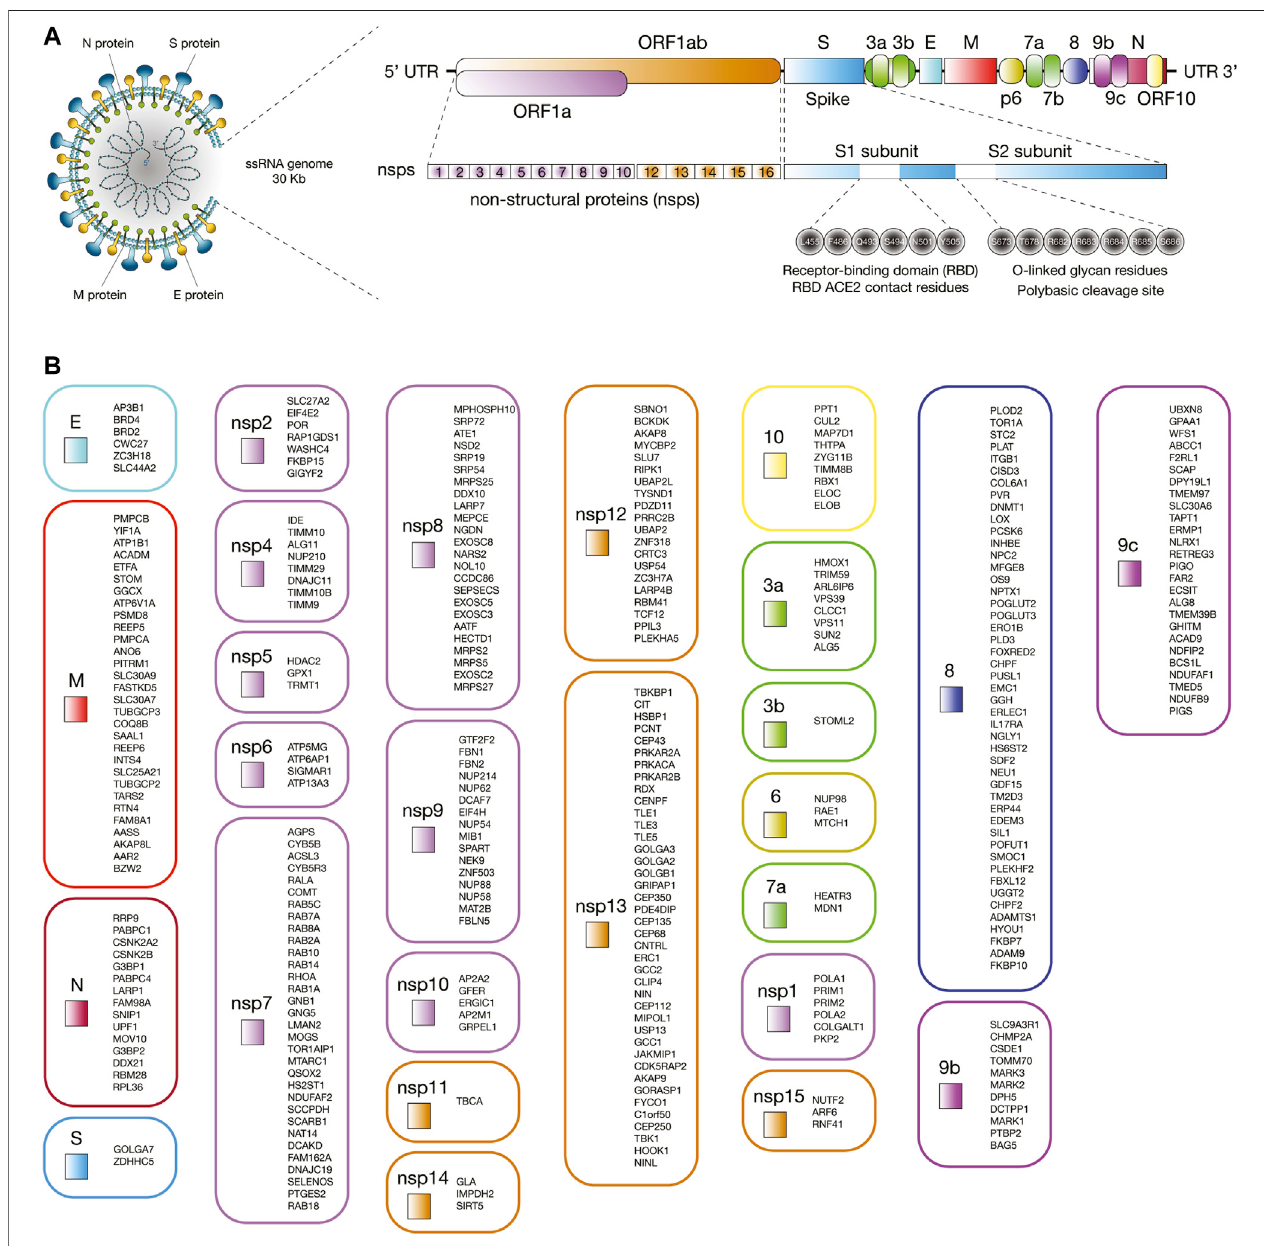
FIGURE1| Interaction betweenhumanproteins and SARS-CoV-2proteins. (A) Proteomicand genomicstructure ofSARS-CoV-2. (B) Human proteins physically associated with SARS-CoV-2 proteins.